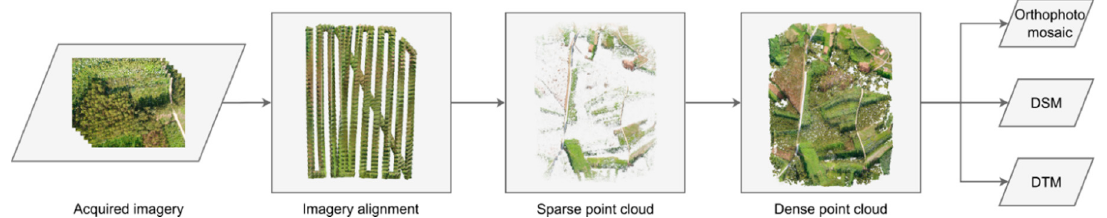
Figure 1. Typical photogrammetric processing pipeline. The acquired imagery goes through an imagery alignment processing, resulting in a sparse point cloud, which in turn, is densified into a dense point cloud, by interpolating it several raster outcomes can result: digital surface model (DSM), digital terrain model (DTM), orthophoto mosaic, among others (depending on the sensor type).